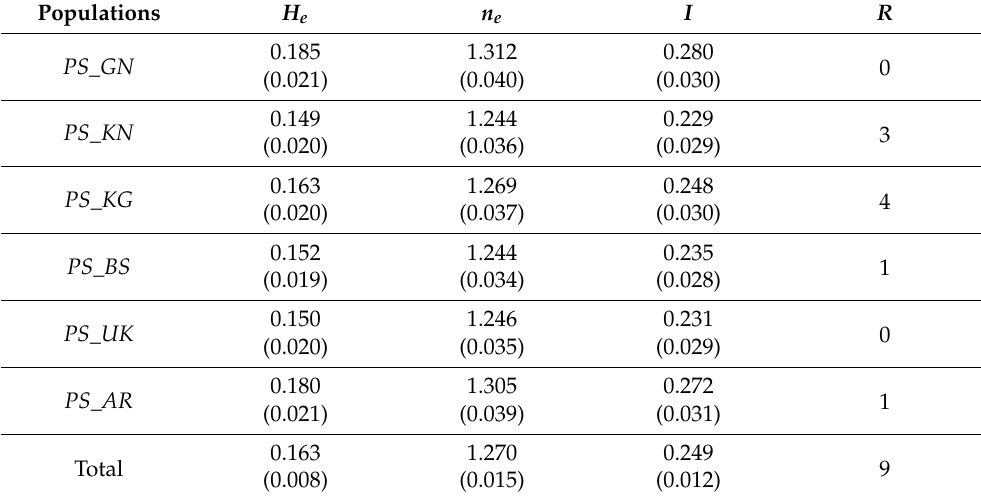
Table 2. Genetic diversity of the studied populations of P. sylvestris .